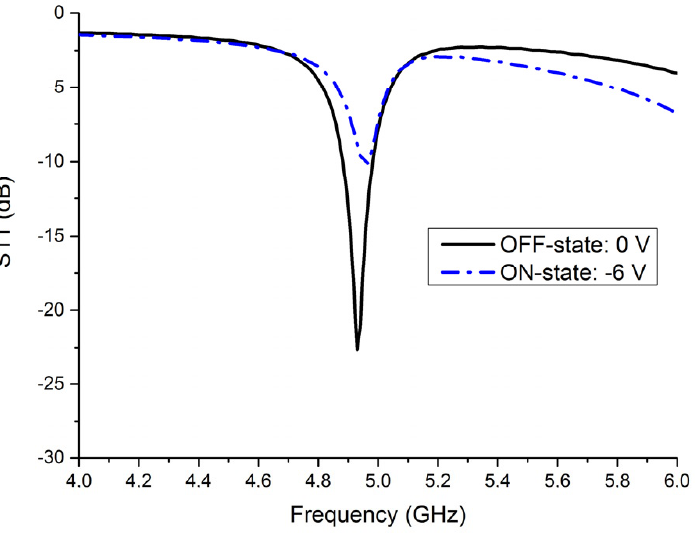
Figure 7 . Measured results of the two linear polarization reconfigurable antenna in both states.